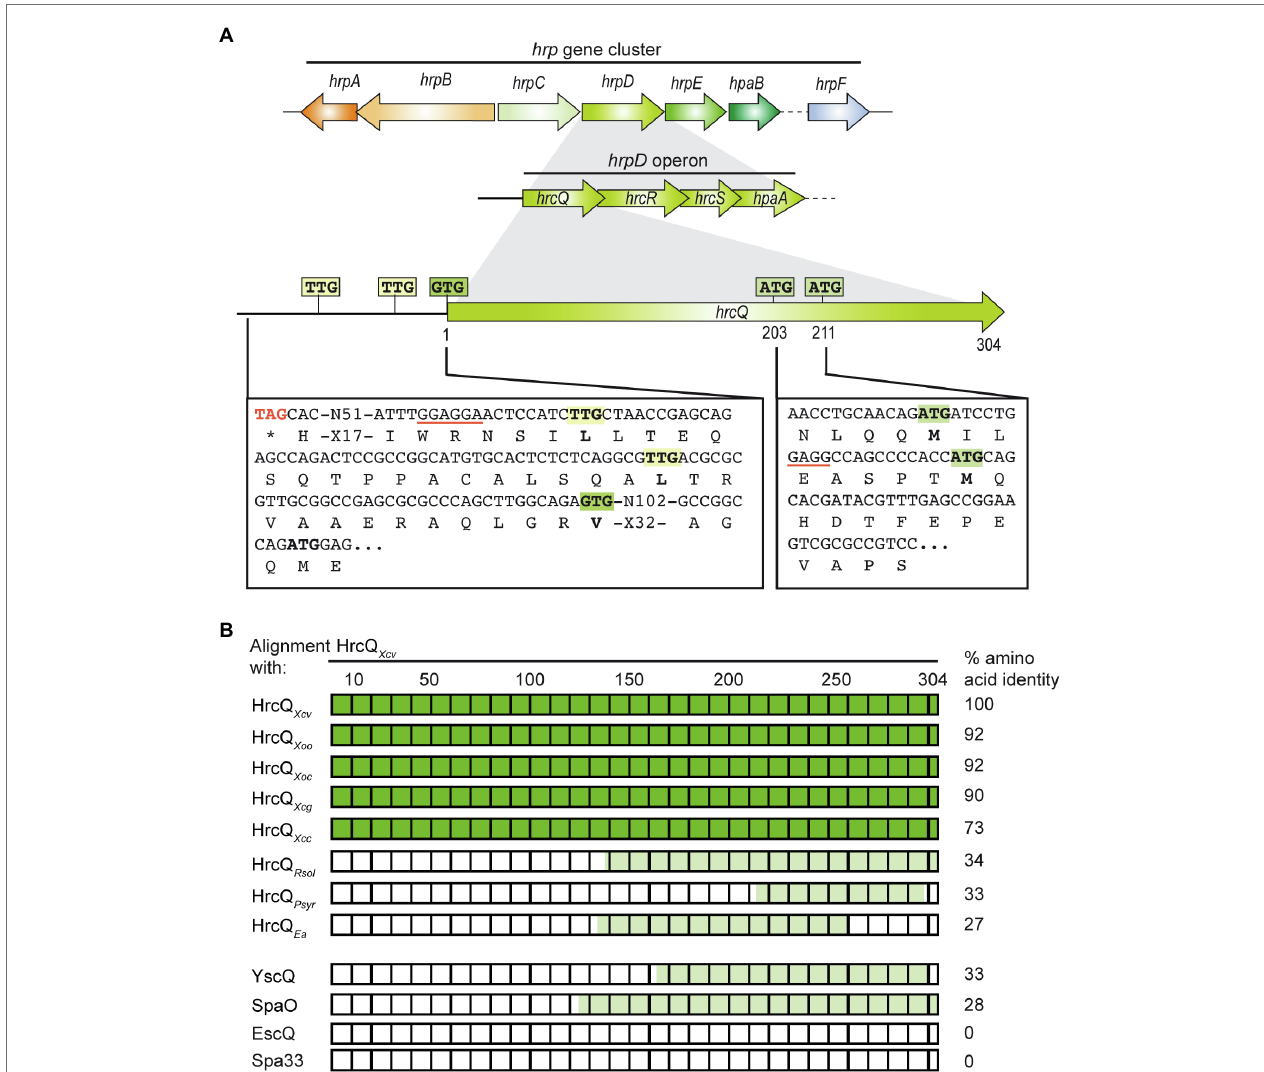
FIGURE 1 | Genetic localization of hrcQ in the hrp gene cluster from Xanthomonas campestris pv. vesicatoria and alignments of HrcQ and SctQ protein sequences. (A) HrcQ is encoded by the first gene of the hrpD operon of the hrp gene cluster. The promoter region upstream of the annotated GTG start codon of hrcQ contains two TTG codons which could serve as alternative translation start sites and are located 13 and 30 codons upstream of the GTG codon. hrcQ also contains two potential internal translation start sites at codon positions 203 and 211. Potential Shine Dalgarno sequences are underlined. Letters refer to amino acids. Operons and genes are represented by arrows. (B) Comparison of HrcQ protein sequences from plant-pathogenic bacteria and SctQ proteins from animal-pathogenic bacteria. HrcQ from X. campestris pv. vesicatoria is represented by rectangles, numbers on top refer to amino acids. The percentage of amino acid identities is indicated on the right side. Protein regions of HrcQ from X. campestris pv. vesicatoria with more than 70% amino acid identities are shown in dark green and regions with lower sequence identities in light green. The following sequences were compared by pairwise sequence alignments: HrcQ from X. campestris pv. vesicatoria ( Xcv , GenBank accession number CAJ22054), HrcQ from X. oryzae pv. oryzae ( Xoo , GenBank accession number AAK08059), HrcQ from X. oryzae pv. oryzicola (GenBank accession number ABH07401), HrcQ from X. citri pv. glycines ( Xcg , GenBank accession number AAP34348), HrcQ from X. campestris pv. campestris ( Xcc , GenBank